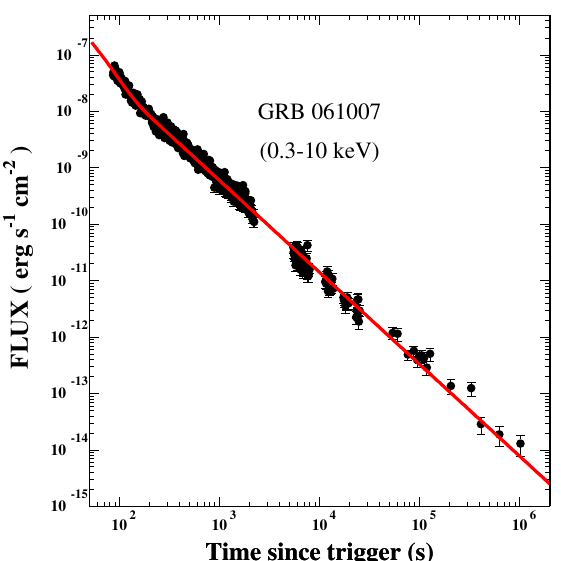
Figure 15. The single power-law best fit to the afterglow of GRB061007 with a “missing jet break” measured with Swift XRT [102]. The best fit temporal index α x = 1.65 ± 0.01 satisfies the CB model prediction α x = β x + 1/2 = 1.60 ± 0.11.